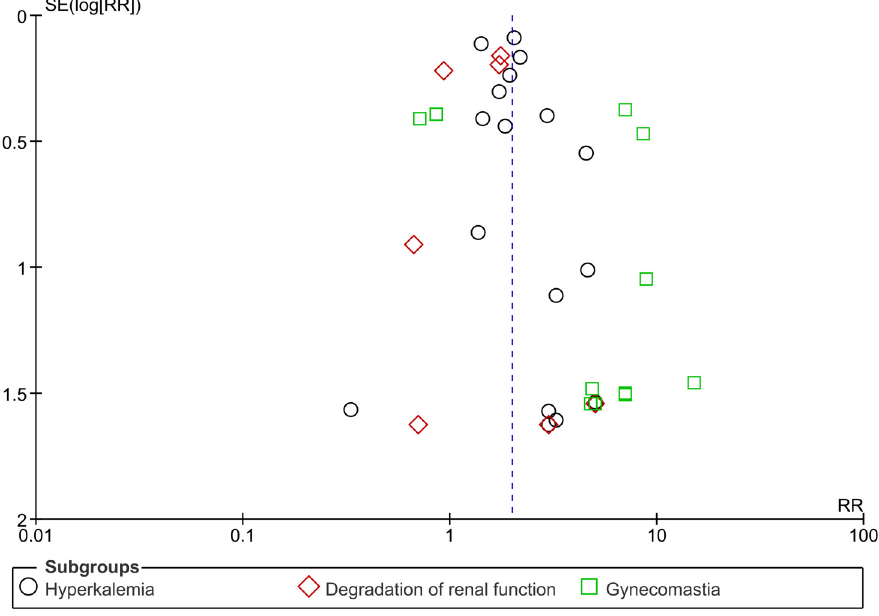
Fig 7. Funnel plot of standard error (log odds ratio) by odds ratio to evaluate publication bias for effect of aldosterone antagonist treatment in inducing common side effects (hyperkalemia, degradation of renal function, gynecomastia) in comparison with placebo/control, in patients with heart failure or myocardial